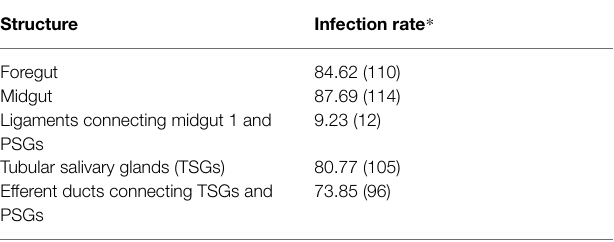
TABLE 2 | Localization of tomato zonate spot virus (TZSV) in different parts of the digestive systems of Frankliniella occidentalis showing TZSV-infected primary salivary glands (PSGs; n =